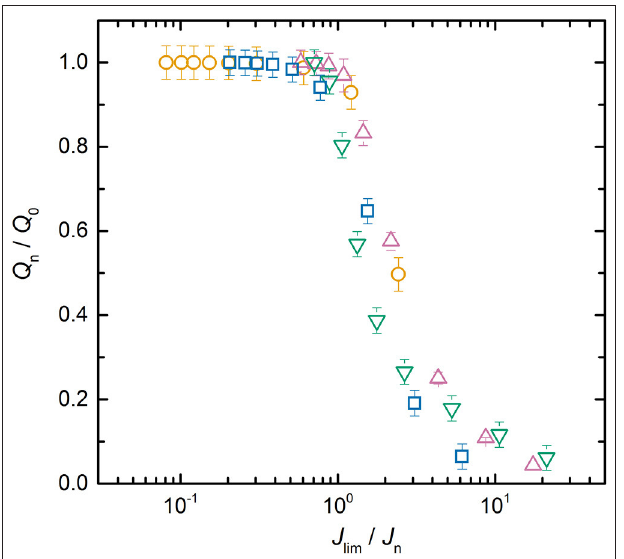
FIGURE 4 | Average normalized capacity, ratio Q n / Q 0 , as a function of J lim / J n for the ( (cid:13) ) LMP(20-18), ( (cid:3) ) LMP(33–36), ( ▽ ) LMP(48-36), and ( △ ) LMP(60-54) batteries.